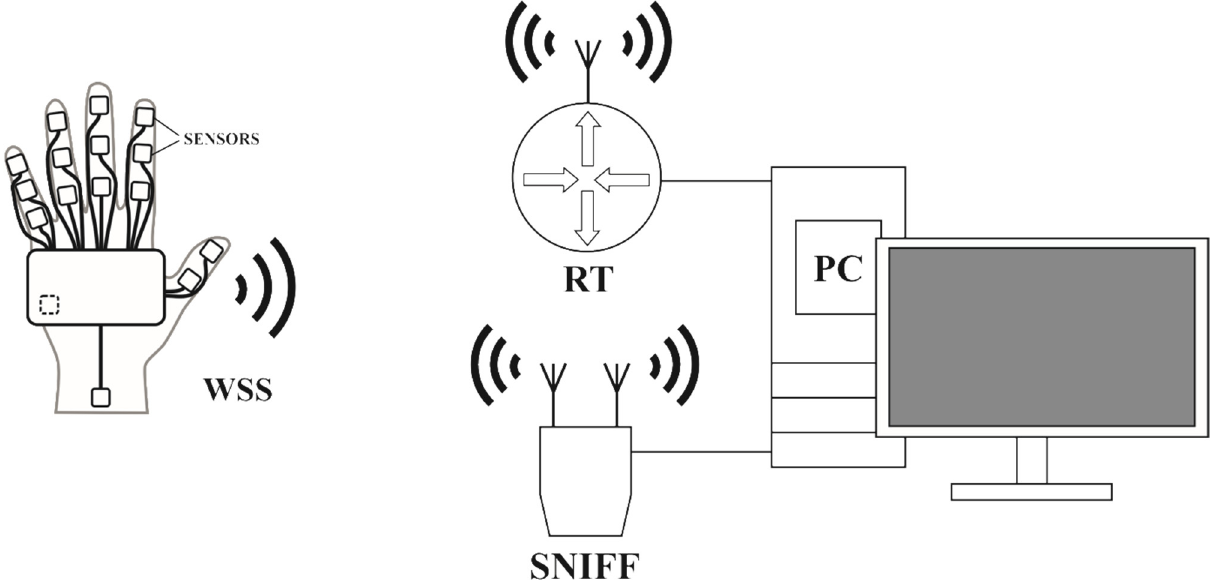
Figure 2. Station for measuring the load on the sensor network.